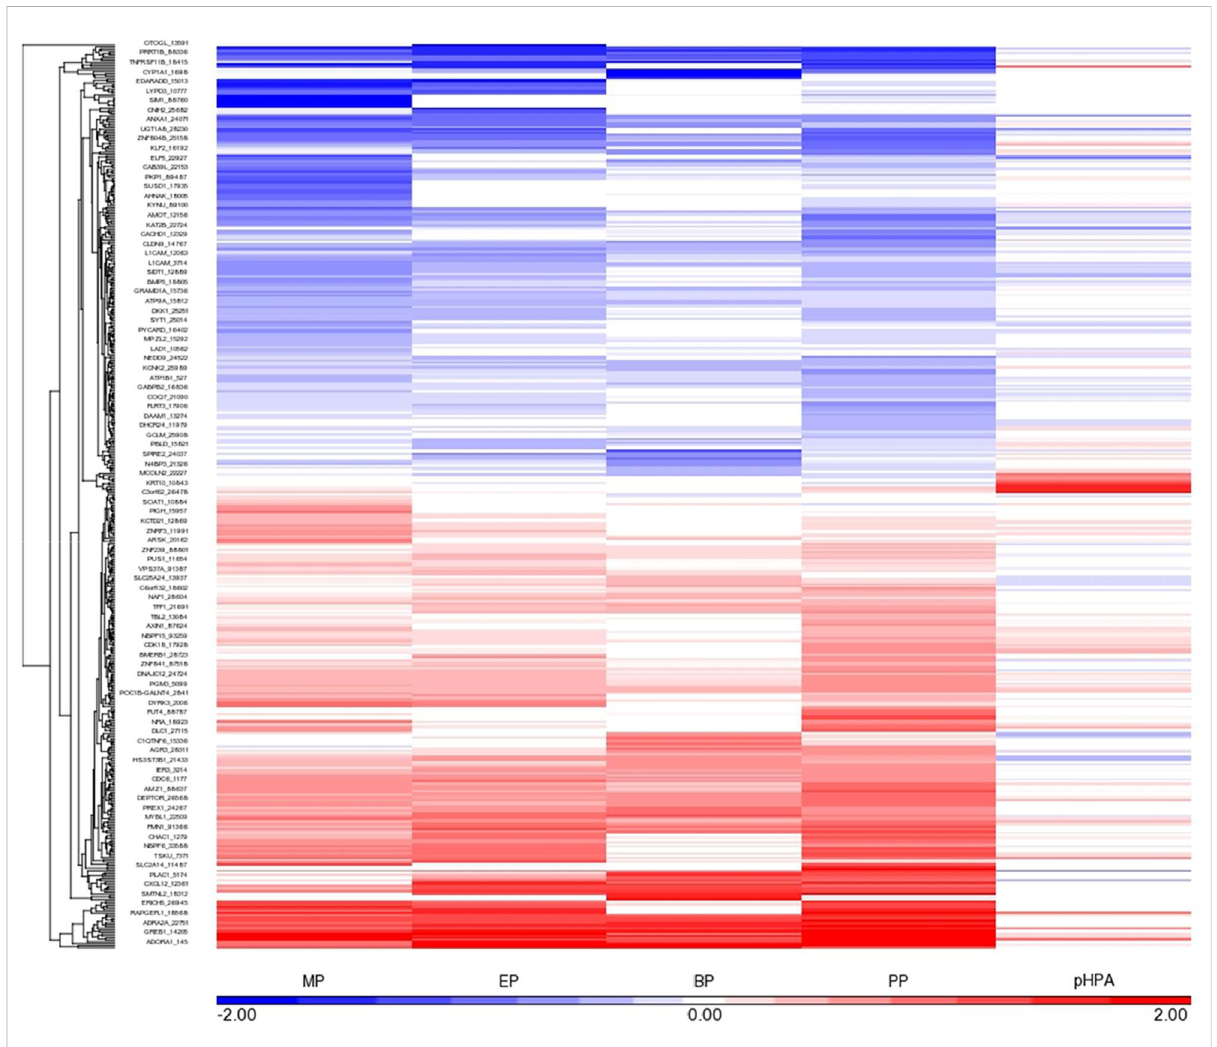
FIGURE 1 Gene expression pro fi le elicited by MP, EP, BP and PP, as well as the main metabolite of these parabens, pHBA (at the highest concentrations tested, 500 μ M, except for BP, shown 50 μ M response) in MCF-7 cells. The genes showing a robust response after exposure to each paraben (FDR < 0.05 and at least 1.2 fold change, up- or down-regulated) are shown in this diagram. Each cell is represented as a color-coded rectangle in which the color indicates the expression value (fold change) of unaffected (white), up-regulated (red) or down-regulated (blue) genes.